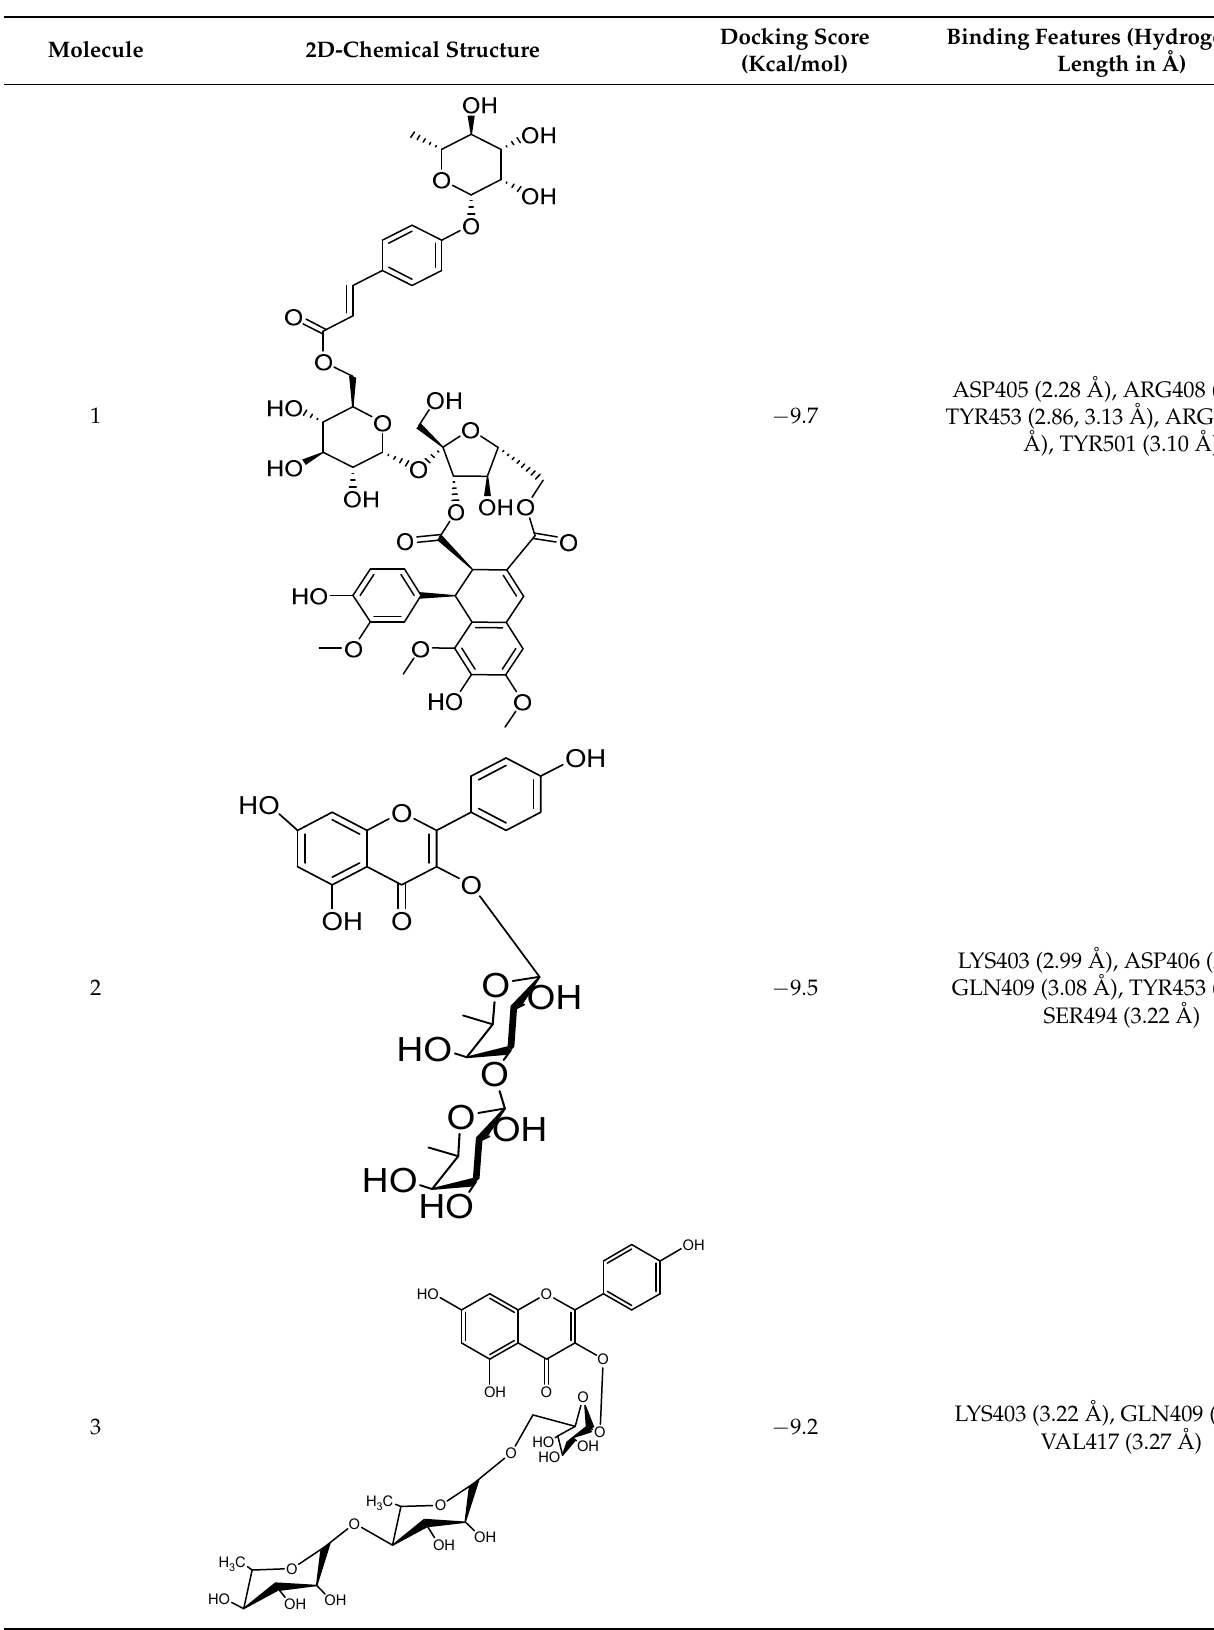
Table 2. Docking scores (in kcal/mol) and binding features for best five Cmds against Omicron BA.1. Molecule